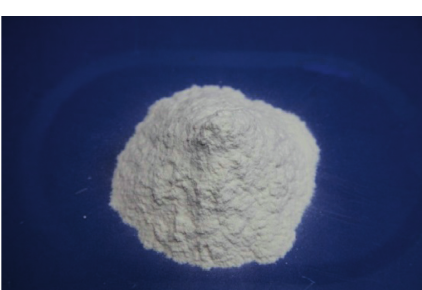
Figure 15: Carboxyl methyl cellulose